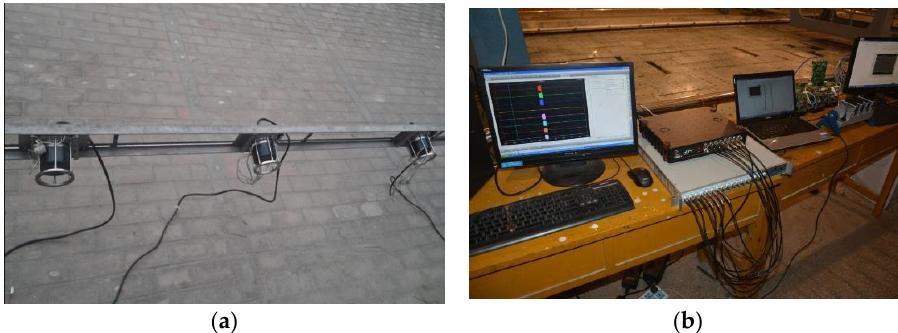
Figure 9. ( a ) The transceiver ( b ) The data acquisition field.